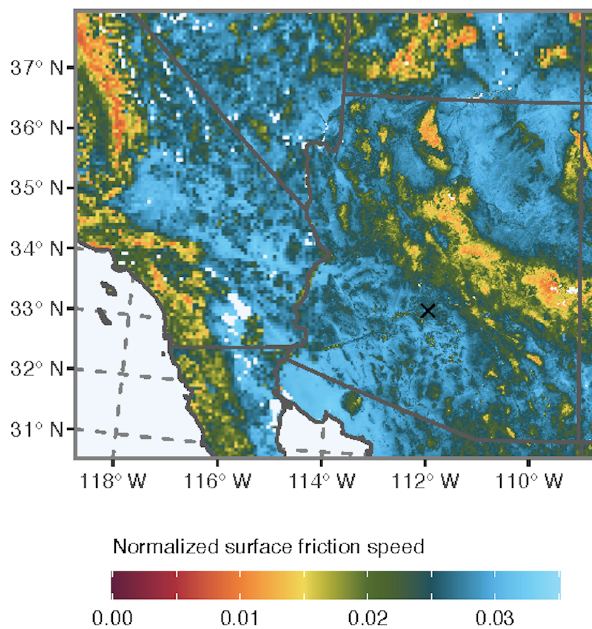
Figure 7. Normalized surface friction speed ( u ns ∗ ) diagnosed from MODIS data. Due to the relatively short duration of our case study event, the u ns ∗ field remains fixed throughout the simulation. The black × marks the location of Phoenix,